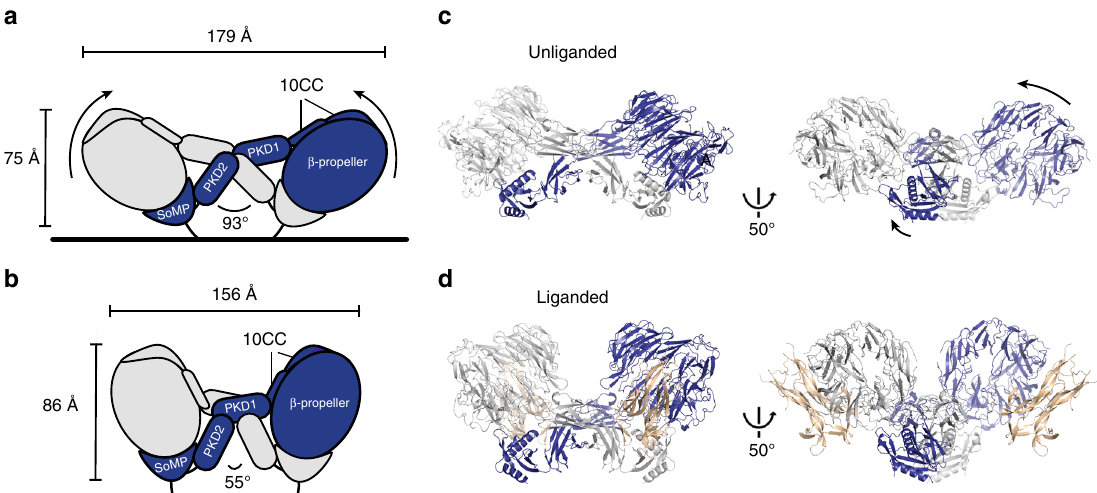
Fig. 5 sSorCS2 – NGF and unliganded sSorCS2 adopt different conformations. SorCS2 in complex with NGF has a different conformation and is more compact compared to the unliganded sSorCS2 structure. a , b domain rearrangement scheme of the conformational plasticity between unliganded ( a ) and liganded SorCS2 ( b ). Dimensions of the sSorCS2 dimers and angle between the PKD2 domains are indicated. NGF has been omitted for clarity. c cartoon representation of the unliganded SorCS2 homodimer in an orientation similar to ( a ) and in a 50° rotated view. The β -propellers are positioned at an angle with their ligand-binding top face close to the cell surface. d sSorCS2 – NGF complex representation identical to ( c ). NGF is now shown (colored beige). In the NGF-bound structure, the β -propellers have moved up and away from the cell surface exposing the top